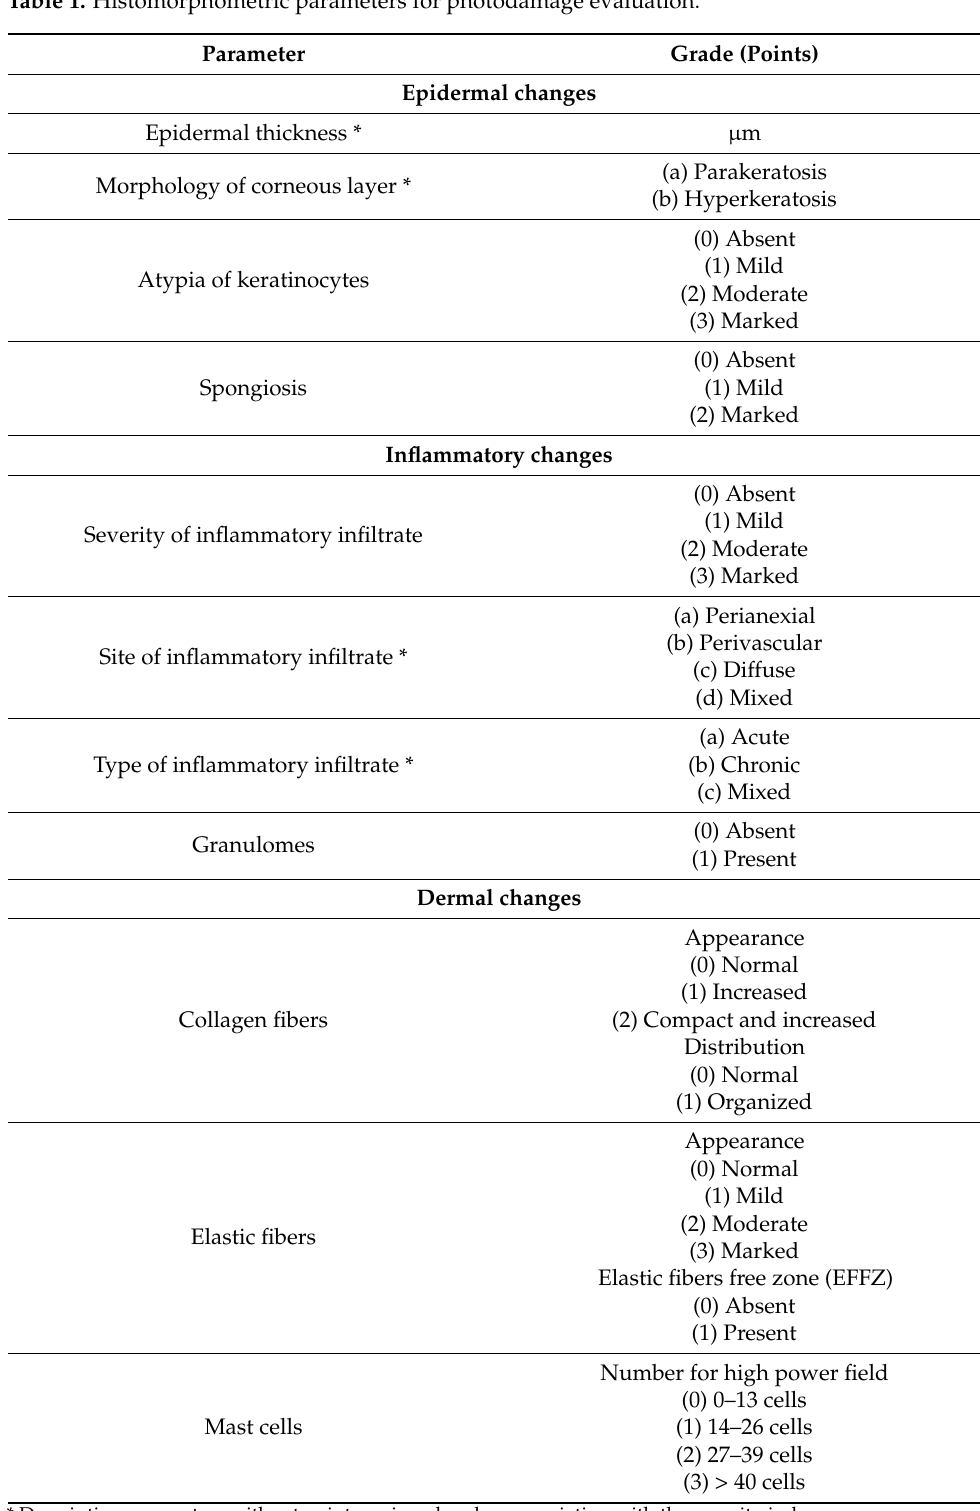
Table 1. Histomorphometric parameters for photodamage